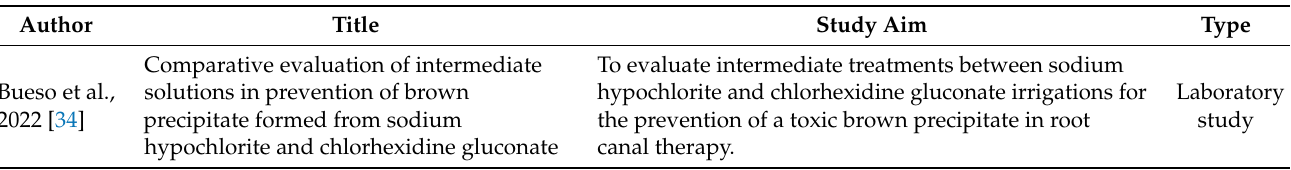
Table 2. Included papers of the